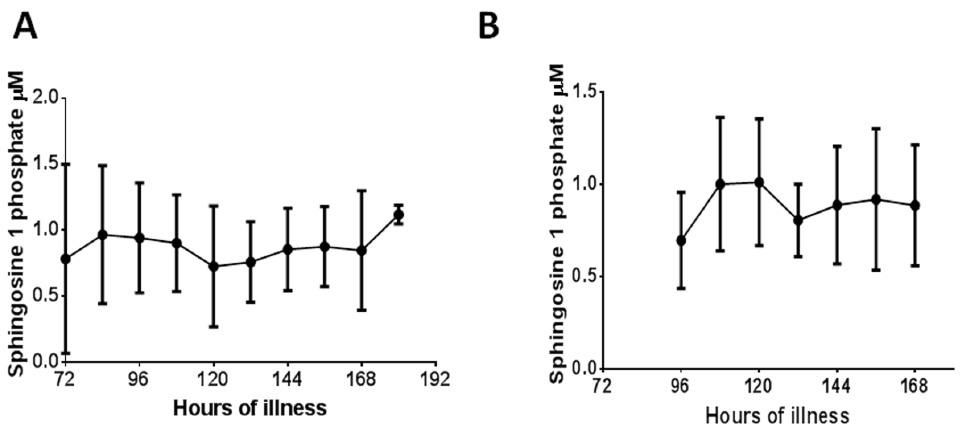
Figure 2. Variation of serum S1P levels throughout the course of the illness in patients with DF and DHF. A: S1P levels in patients with DHF (n=22). The bars indicate the mean and the standard error of the mean. The time of onset of fever was considered as 0 hours and the number of hours of illness considered from the time of onset of fever. B: S1P levels in patients with DF(n=10). The bars indicate the mean and the standard error of the mean. The time of onset of fever was considered as 0 hours and the number of hours of illness considered from the time of onset of fever.